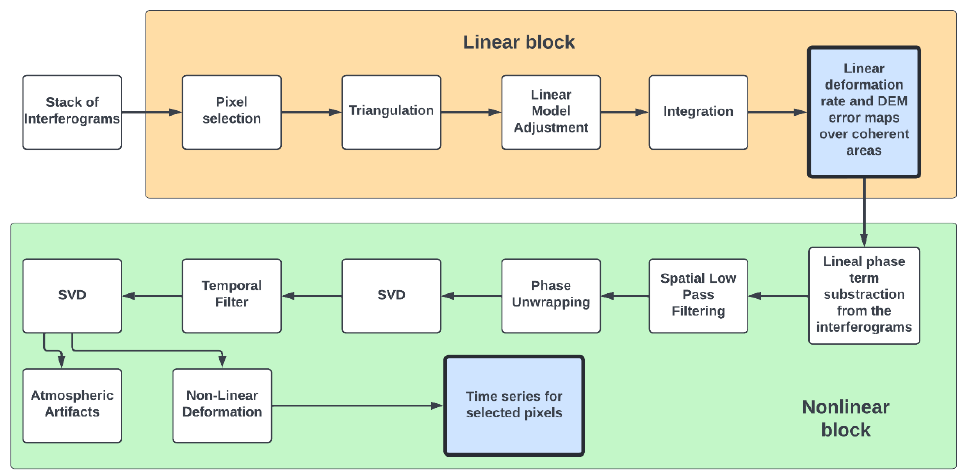
Figure 2. Workflow of the CPT algorithm for time series calculation. One of the main differences between the CPT technique with other coherence-based techniques is the initial estimation of the linear term of the displacement (Linear block).